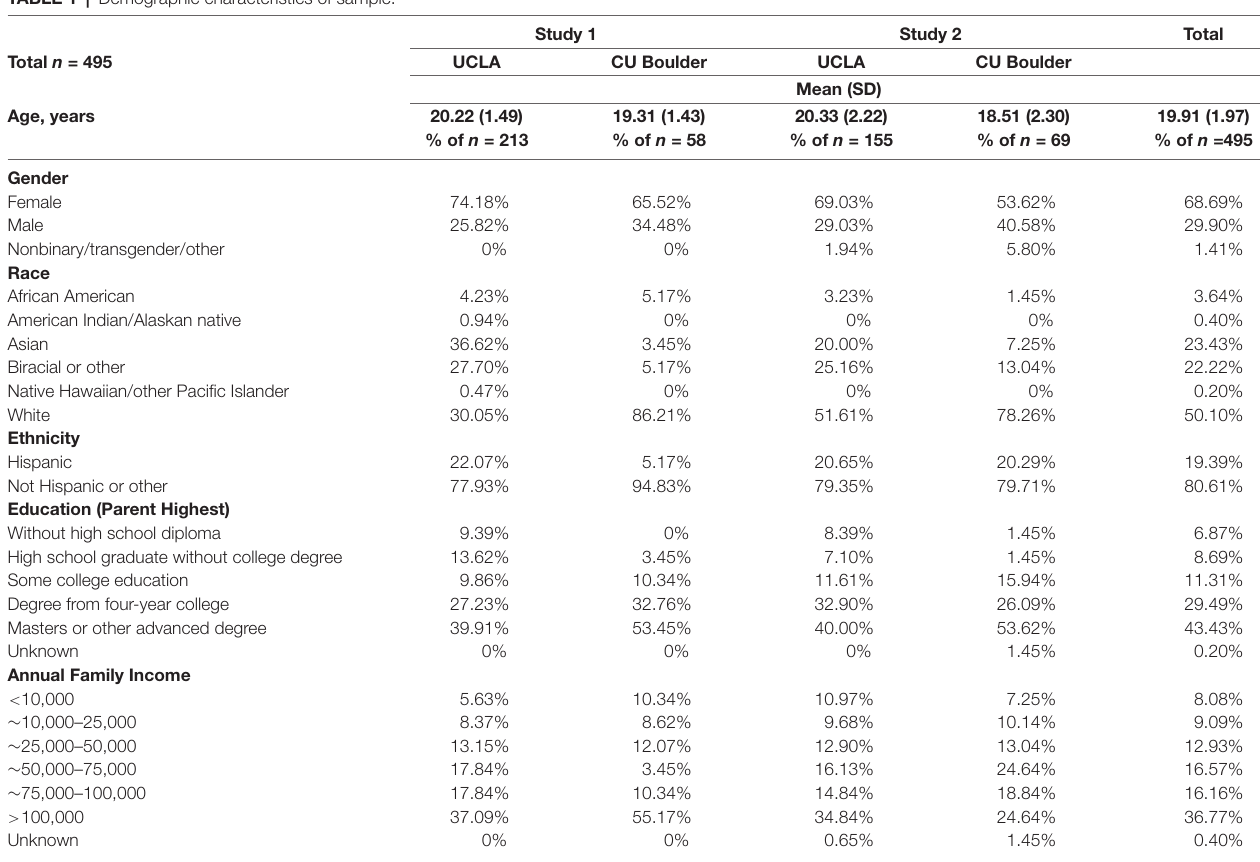
TABLE 1 | Demographic characteristics of